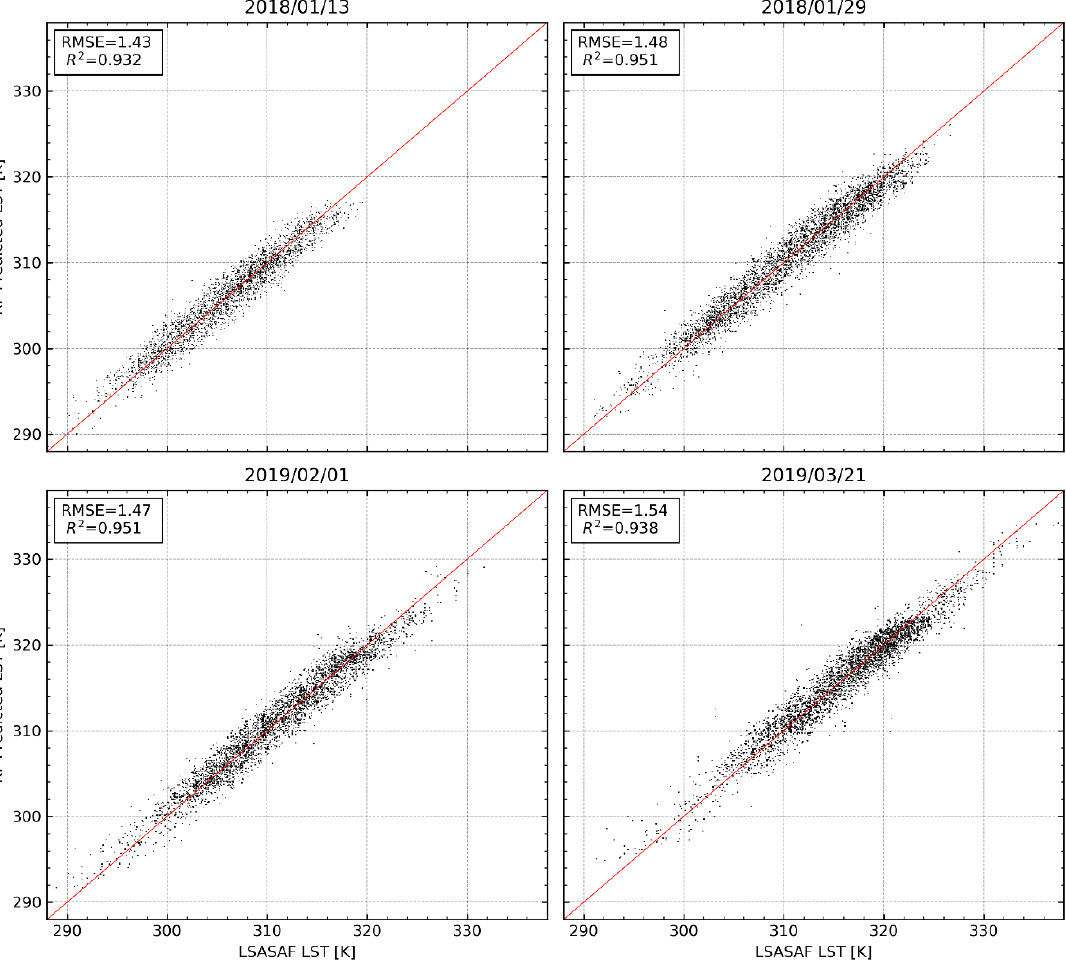
Figure 4. Relationship between LSA-SAF LST and random forest (RF) model-predicted LST at 3km for each day corresponding to the four Landsat 8 overpass dates used in the study.